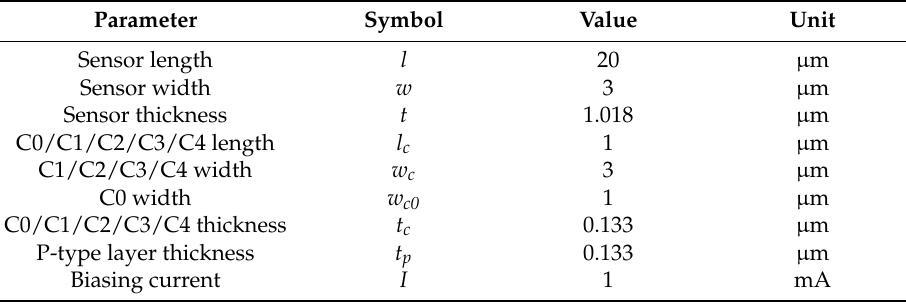
Table 3. Cross-shaped 3D Hall device parameters and operating